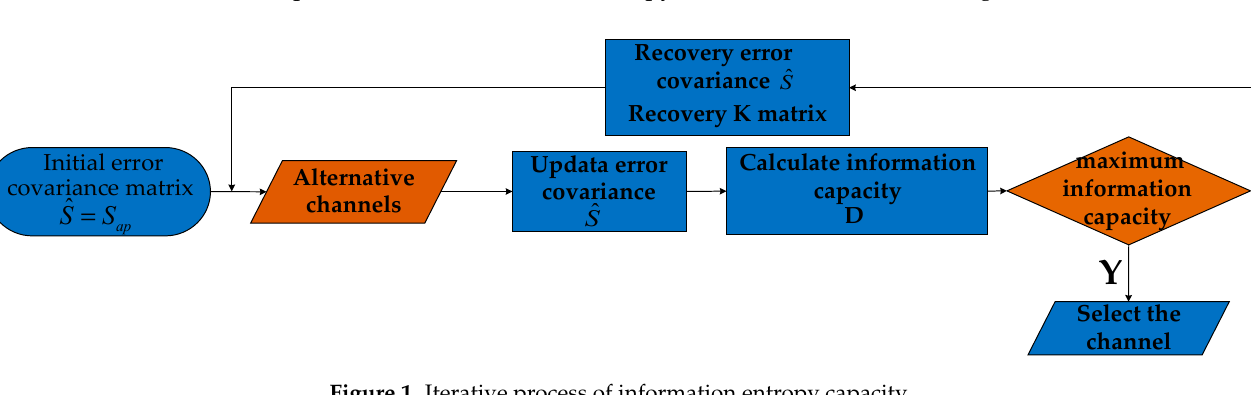
Figure 1. Iterative process of information entropy capacity.